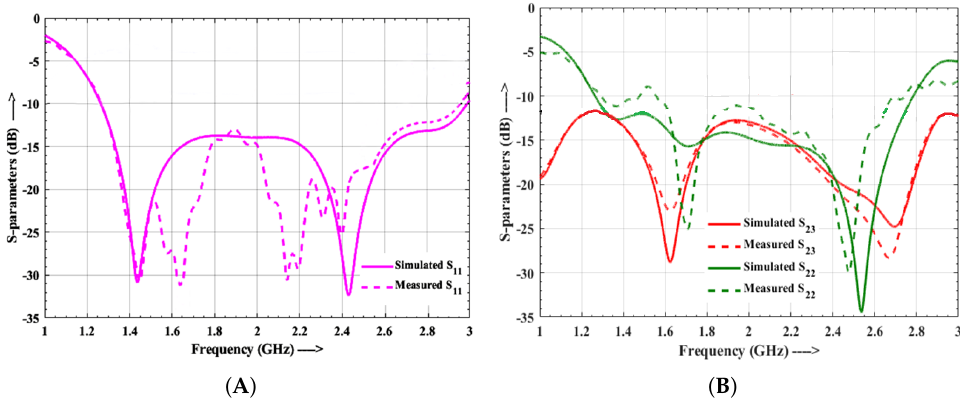
Figure 13. EM vs. Measured S-parameters for ( A ) S 11 ; ( B ) S 23 , S 22 for θ c = 55 ◦